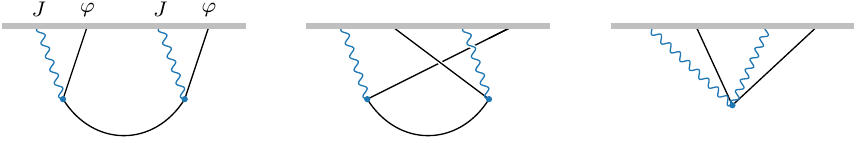
Figure 3. Illustration of the different contributions to the Abelian Compton correlator. Consistency requires the exchange of particles in both the s and t -channels, along with a particular contact contribution. In the recursive construction of the correlator, these contributions are linked together by the total energy